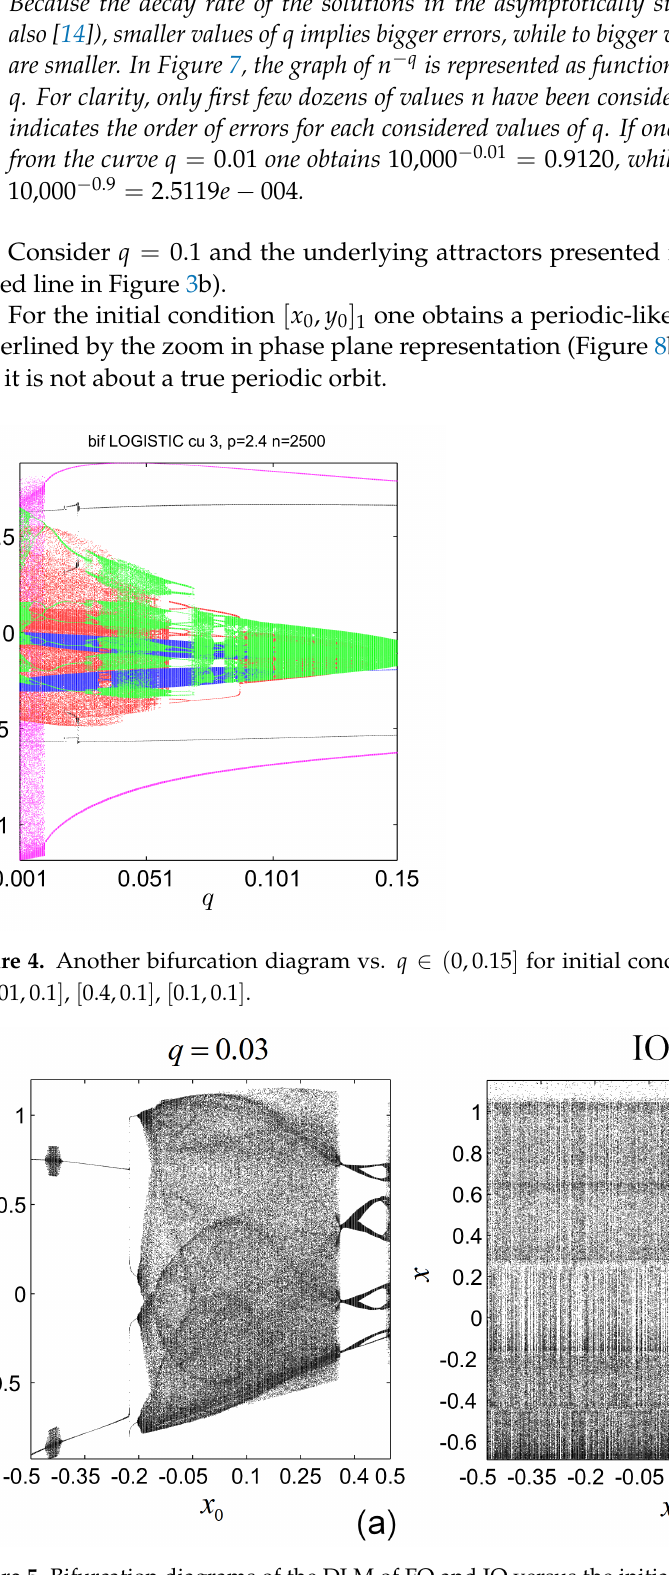
Figure 5. Bifurcation diagrams of the DLM of FO and IO versus the initial conditions x 0 ∈ [ − 0.5,0.5 ] and y 0 = 0.8. ( a ) The FO case q = 0.03; ( b ) the IO